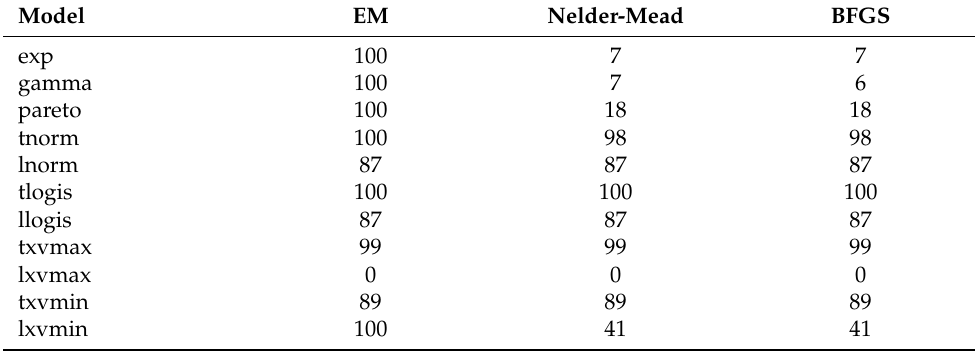
Table 3. The number of converged estimations (SS1B).